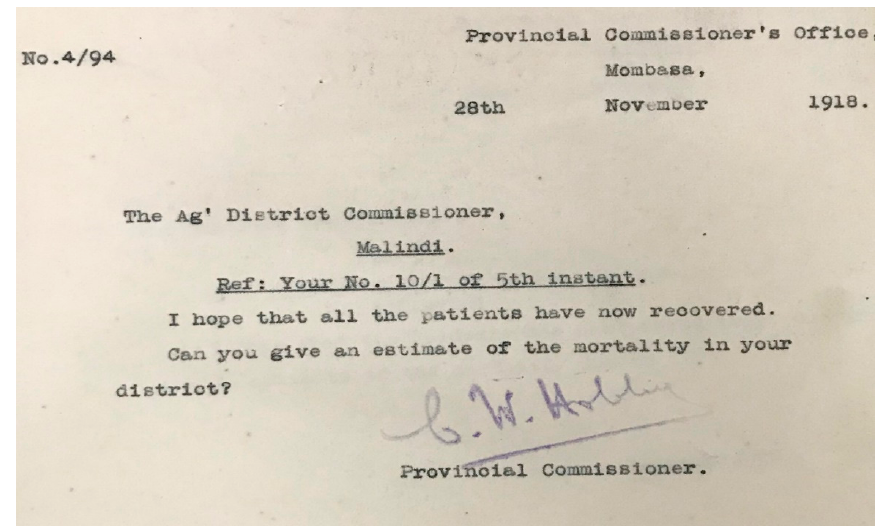
Figure 1. Coast Province administration first letter sent to one of the District Officers requesting the 1918 pandemic influenza deaths. (Source: National Archives Library-KNA, Nairobi Kenya).